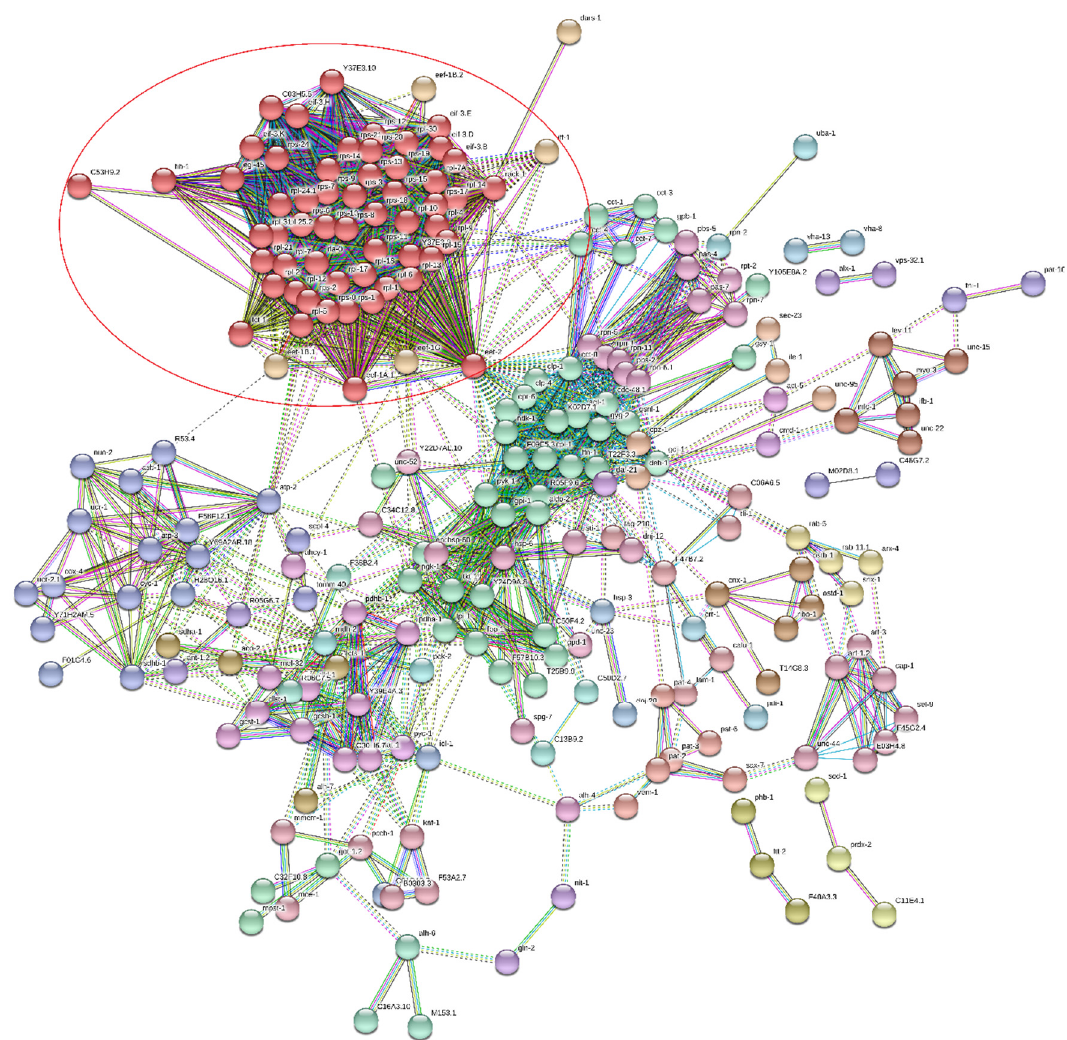
Figure 9. Network analysis of sample A. The network nodes are proteins, and the edges represent the predicted functional associations. The highlighted red cluster is related to ribosomal proteins.